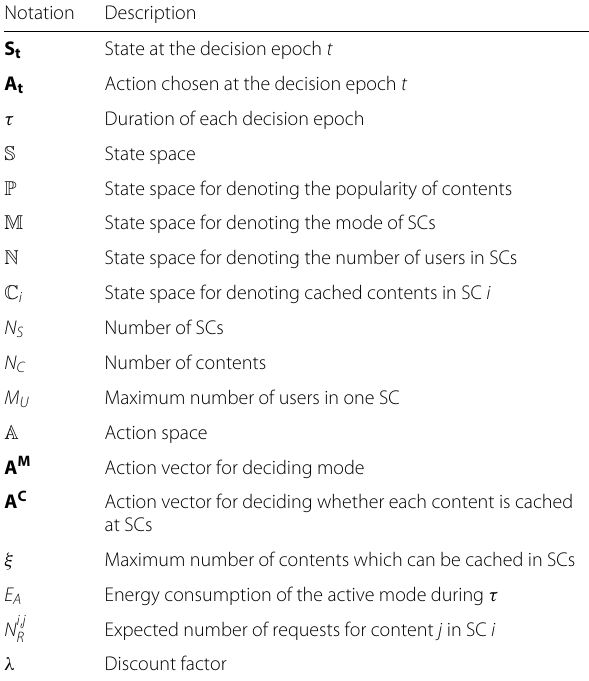
Table 1 Summary of